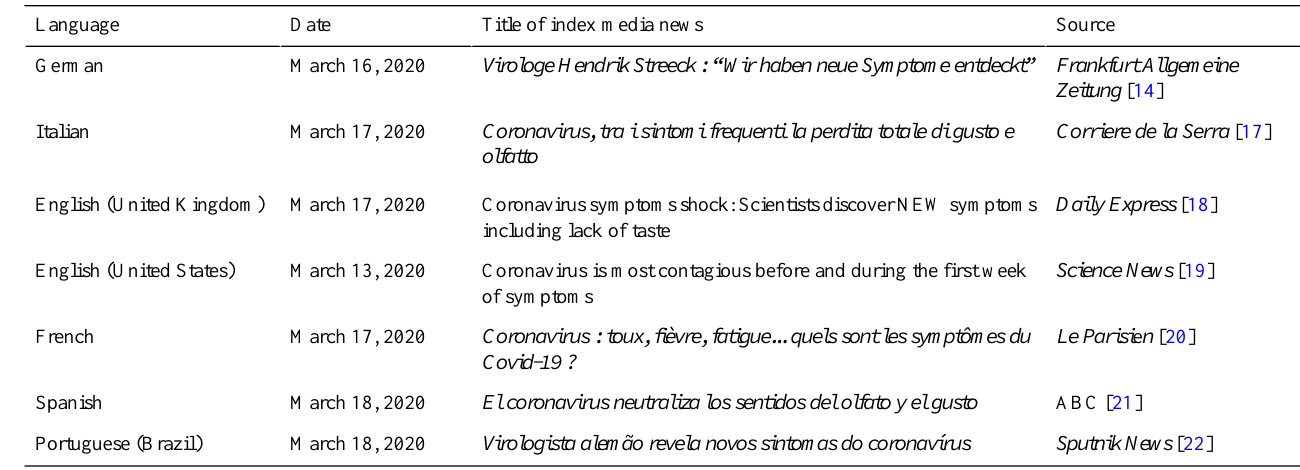
Table 4. Media coverage on the identification of anosmia and ageusia as COVID-19